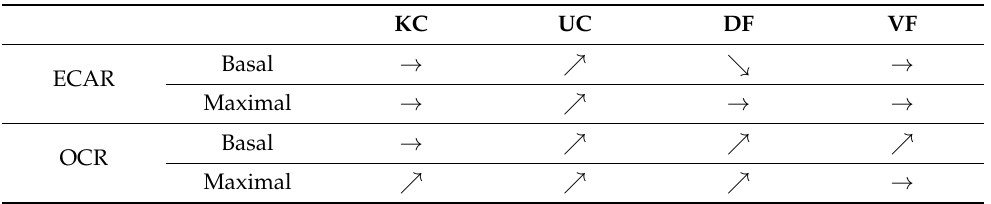
Table 2. Summary of the metabolism tendency results for all cell types cultured in SFM compared to FBSCM.